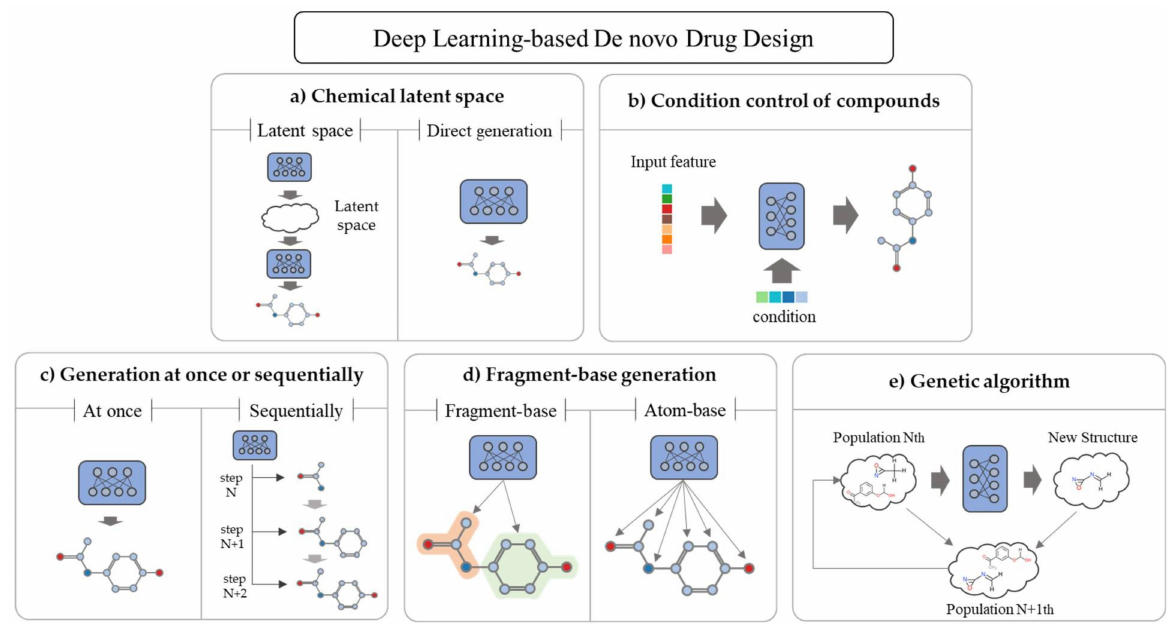
Figure 3. Deep learning-based de novo drug design. DL-based de novo drug design can be classified into five types according to function and method. ( a ) Classification according to the presence or absence of chemical latent space using manifold learning. ( b ) Classification according to the existence of condition control function. ( c ) Classification based on sequential generation. ( d ) Classification based on whether the molecule is produced in fragments or atoms. ( e ) Classification according to genetic algorithm using